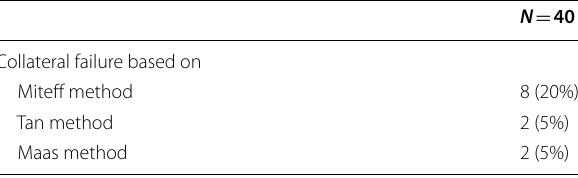
Data expressed as frequency (percentage)